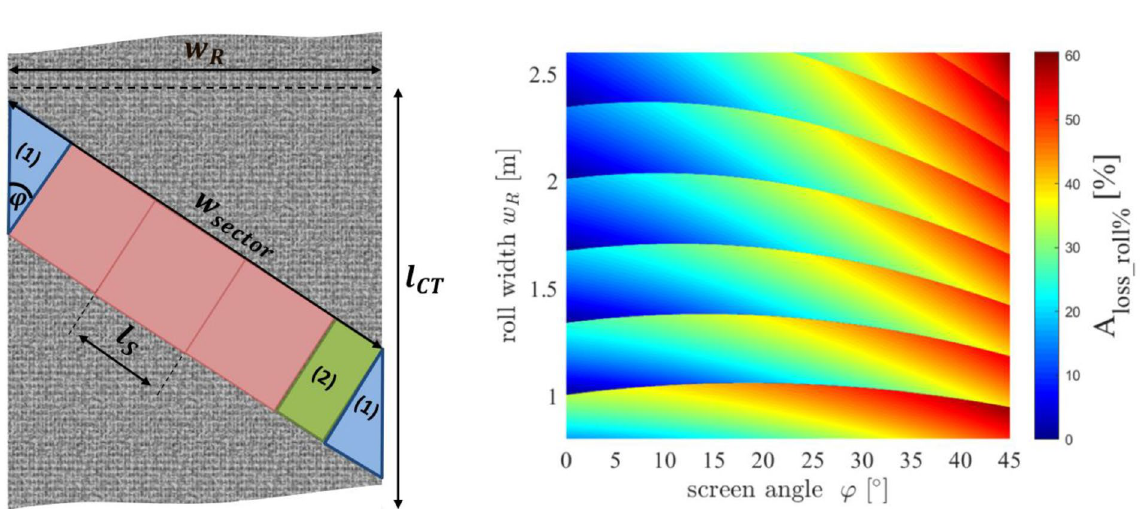
Figure 9. On the left, a schematic illustration for cutting losses of mesh during screen production is presented. Depending on the screen angle φ, the number of sheets with a side length l s which fit into the parallelogram shaped sector is shown. The cutting losses are defined by two triangles with the same size and a remaining rectangle (defined by the residual of sheets fitting into the sector). On the right, a calculation of Eq. (9) for the relative cutting losses of an entire mesh roll is shown for different roll width w r and screen angles φ. The length of the clamping table was set to l ct = 5